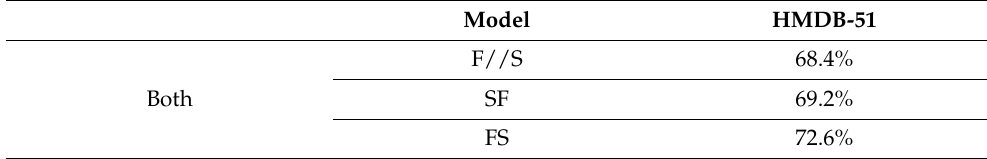
Table 2. Comparing the performance of our model with different sequences.